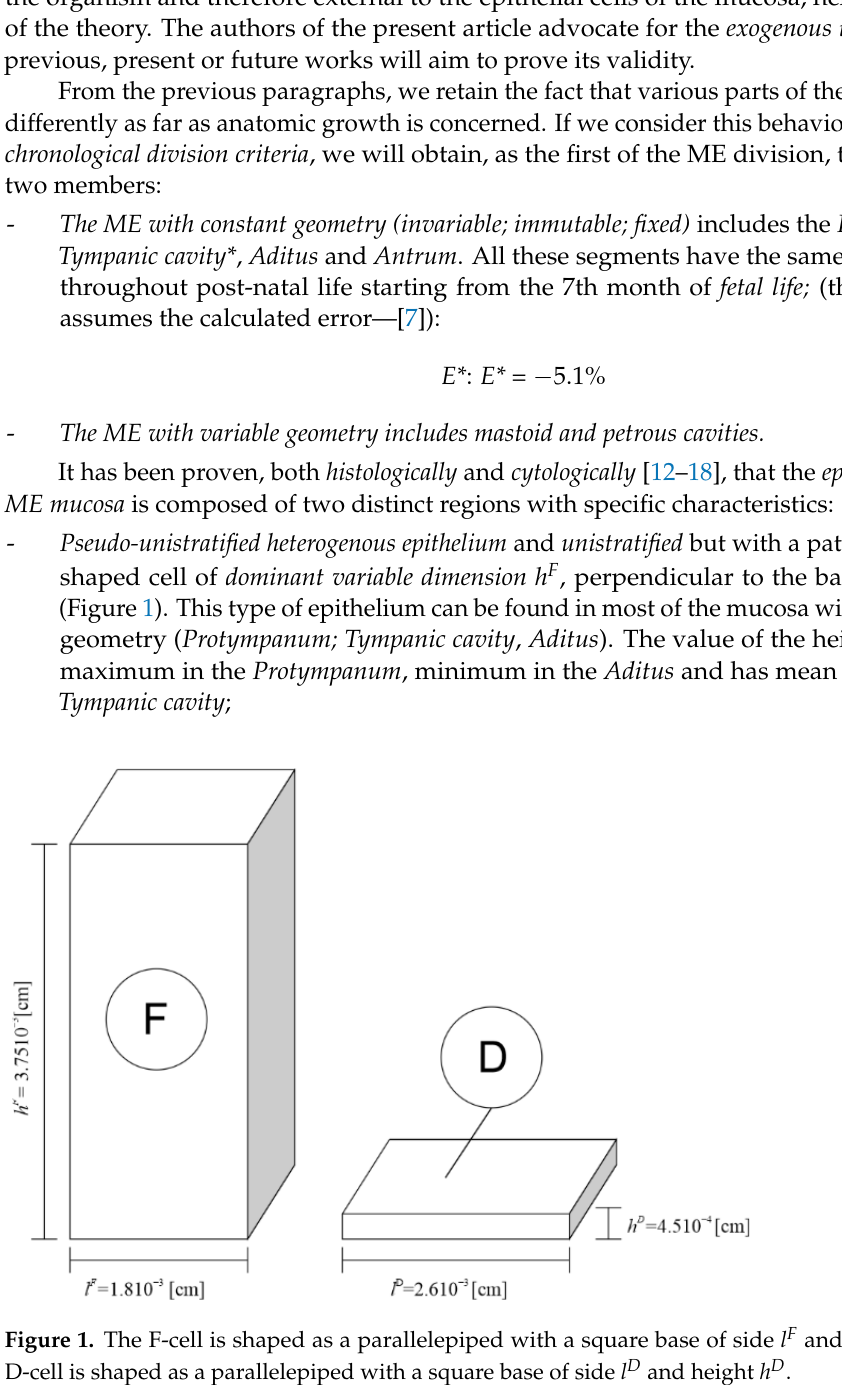
Figure 1. The F-cell is shaped as a parallelepiped with a square base of side l F and height h F ; the D-cell is shaped as a parallelepiped with a square base of side l D and height h D . - Homogenous unistratified epithelium made up of pavement cells of dominant dimension parallel to the basal membrane and constant minimal dimension h D perpendicular to the basal membrane (Figure 1). This is the epithelium of the mucosa covering the Antrum ( central cavity of fixed geometry ), and the peripheral cavities of the ME (mastoid and petrous)—ME of variable geometry